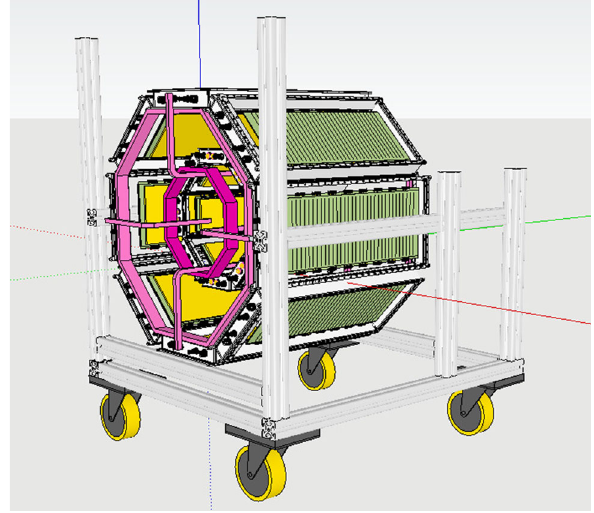
Fig. 3 Sketch of the structure of T0 detector, which is composes of inner and outer layers. Each layer includes eight